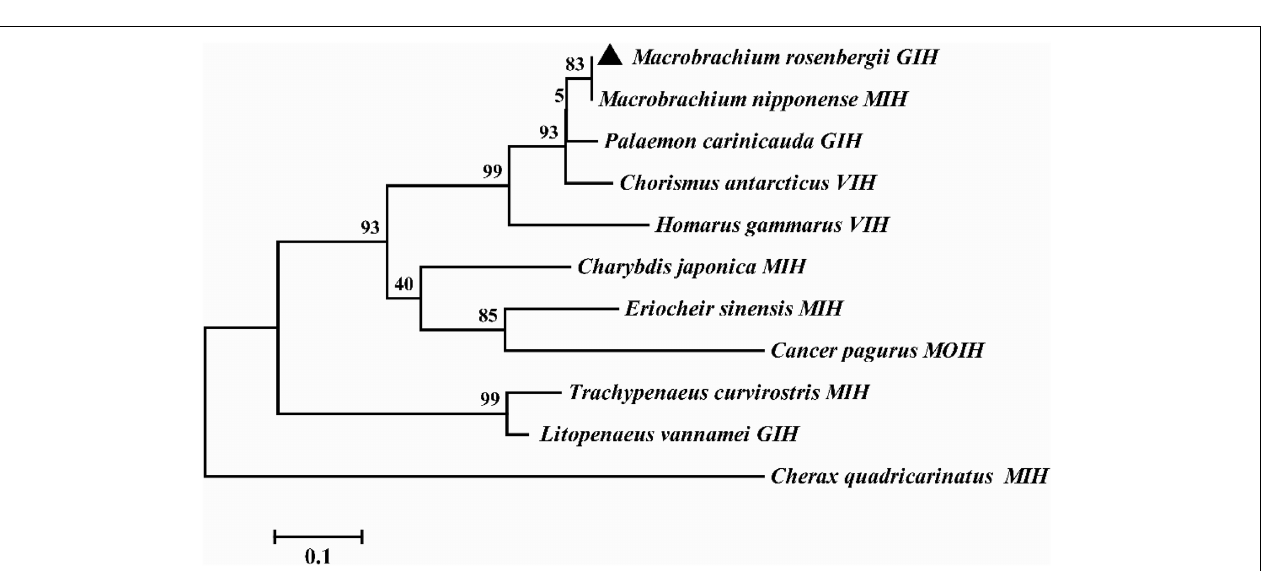
FIGURE 3 | Phylogenetic tree of Mr GIH with other homologous species. The amino acid sequences of Mr GIH from M. rosenbergii (marked with a triangle) and other species are listed below: Macrobrachium nipponense (AEJ54622.1), Palaemon carinicauda (AIJ49750.1), Chorismus antarcticus (ANQ38670.1), Homarus gammarus (ABA42181.1), Charybdis japonica (ACD11361.1), Eriocheir sinensis (AAQ81640.1), Cancer pagurus (CAB61424.1), Trachypenaeus curvirostris (AAL55259.1), Cherax quadricarinatus (AWK57516.1), Litopenaeus vannamei (KF879913.1).